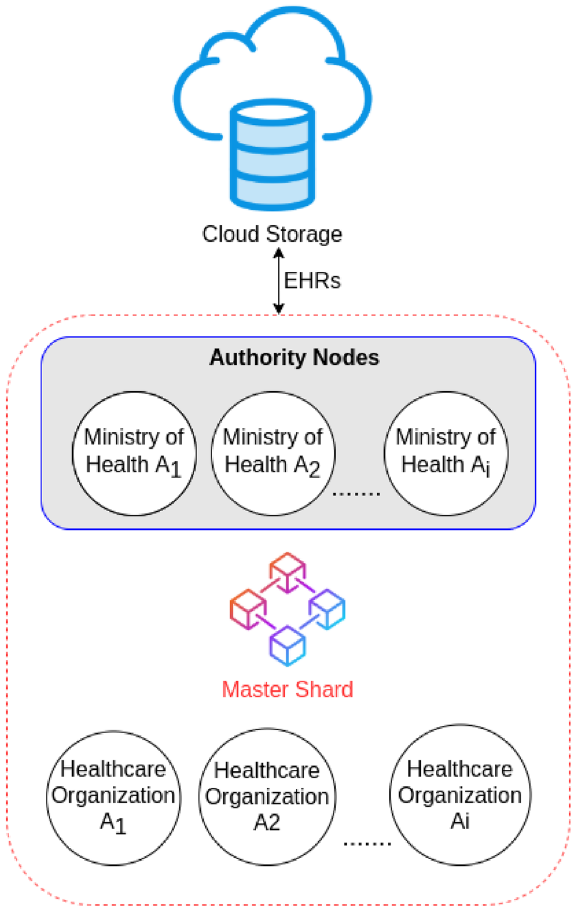
Figure 10. Master